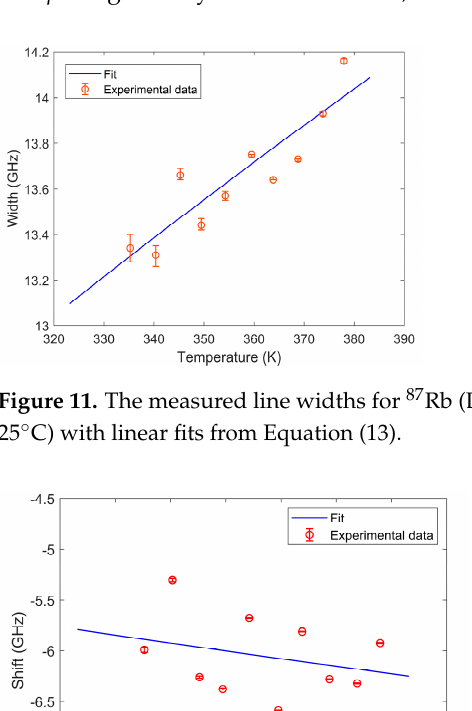
Figure 12. Measured shifts for 87 Rb (D1) as a function of temperature for N 2 (700 Torr at 25°C) with linear fits derived from Equation (14).